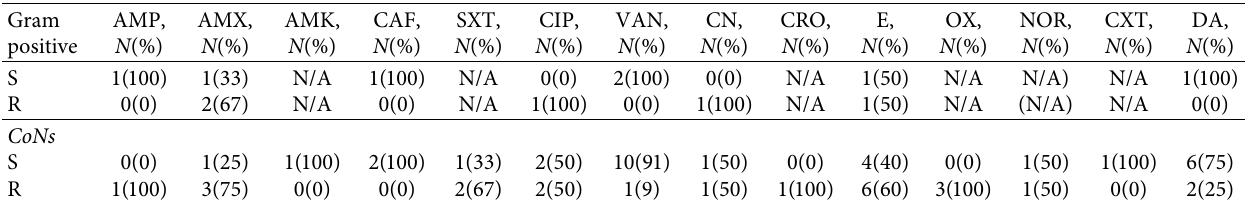
Table 5: Antimicrobial susceptibility profile of Gram-negative bacterial isolates at University of Gondar Comprehensive Specialized Hospital, Northwest Ethiopia, 2021.